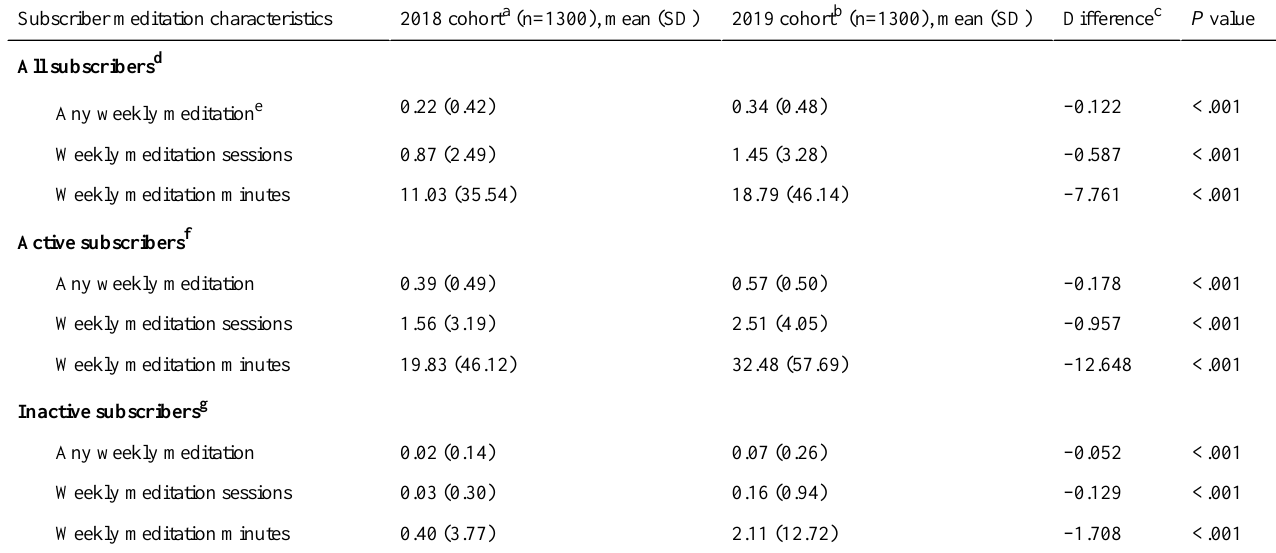
Table 1. Calm app usage between 2018 and 2019 cohorts during the full study